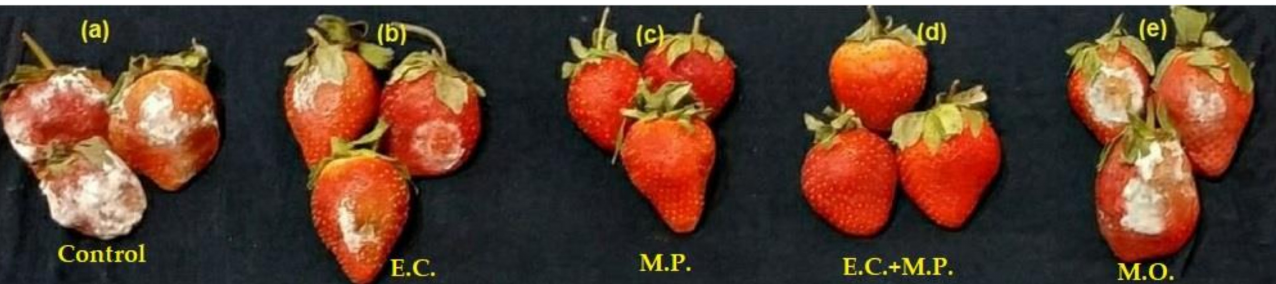
Figure 3. Visual observation of the treated fruits with oils after 18 days of storage at 5 ◦ C. ( a ) untreated fruits; and treated fruits with ( b ) E. camaldulensis var obtusa EO; ( c ) M. piperita EO; ( d ) E. camaldulensis var obtusa and M. piperita mix EOs (1/1 v / v ) and ( e ) M. oleifera FO.